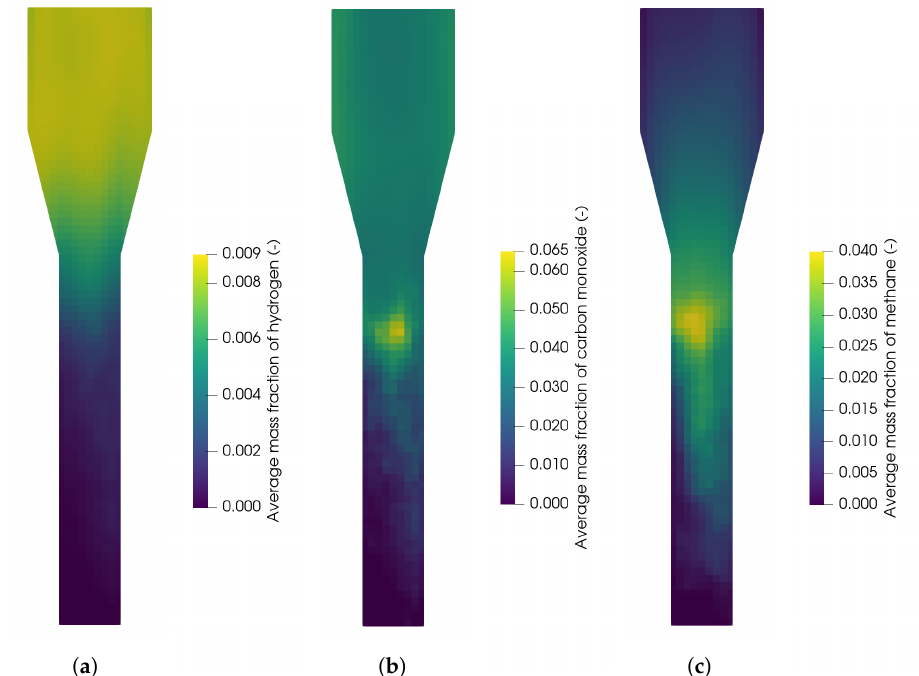
Figure 18. Average mass fraction of ( a ) hydrogen, ( b ) carbon monoxide, and ( c ) methane in the the fuel reactor at 820